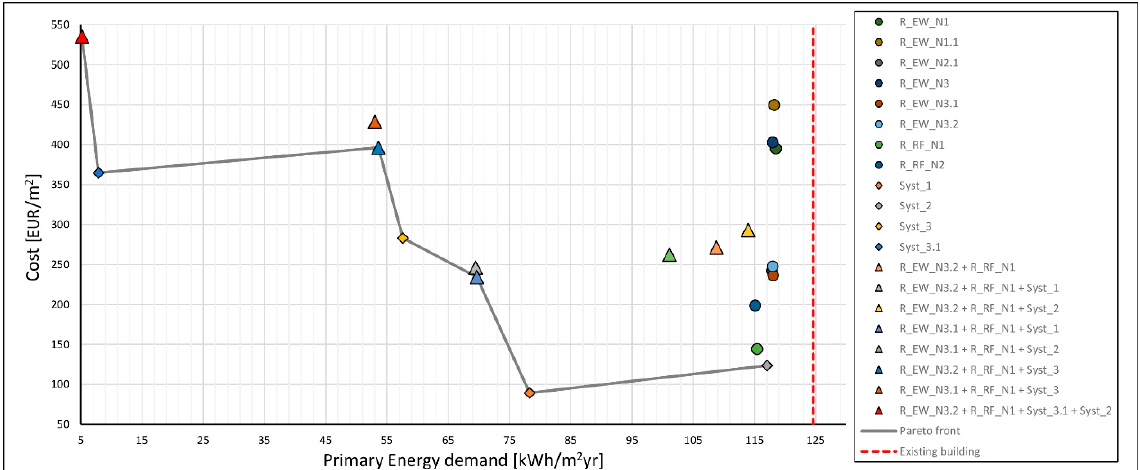
Figure 10. Cost-optimality method results for financial scenario (discount factor equal to 4%) for both single redevelopment measures and their combinations for Rodari school. The red line in the graph shows the primary energy consumption for the existing building.